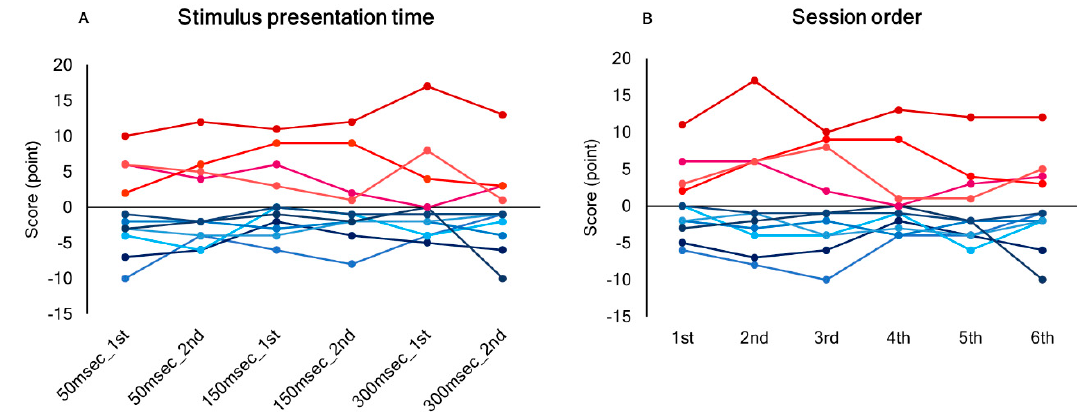
Figure 3. Individual scores of line length judgement task compared between ( A ) stimulus presentation times and ( B ) for session order (between 6 preliminary sessions). The red lines indicate a rightward bias, and the blue lines indicate a leftward bias.